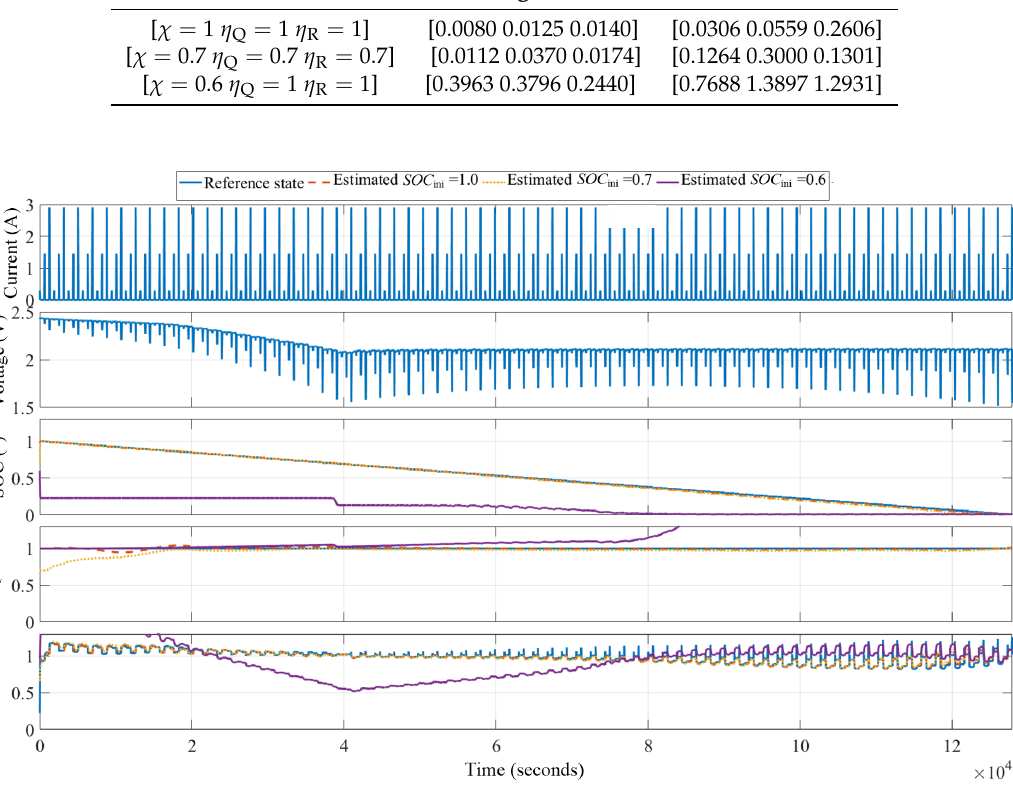
Figure 5. The mixed pulse discharge test profile and the estimated results for the various SOC ini values at the fresh Li-S cell. It shows the capability of the estimator to converge to the states in the cases when the SOC ini is set to match the reference SOC value or to be mismatched, but still on the high voltage plateau as the SOC reference was. If the SOC ini was instead on the low voltage plateau, the estimator was not able to